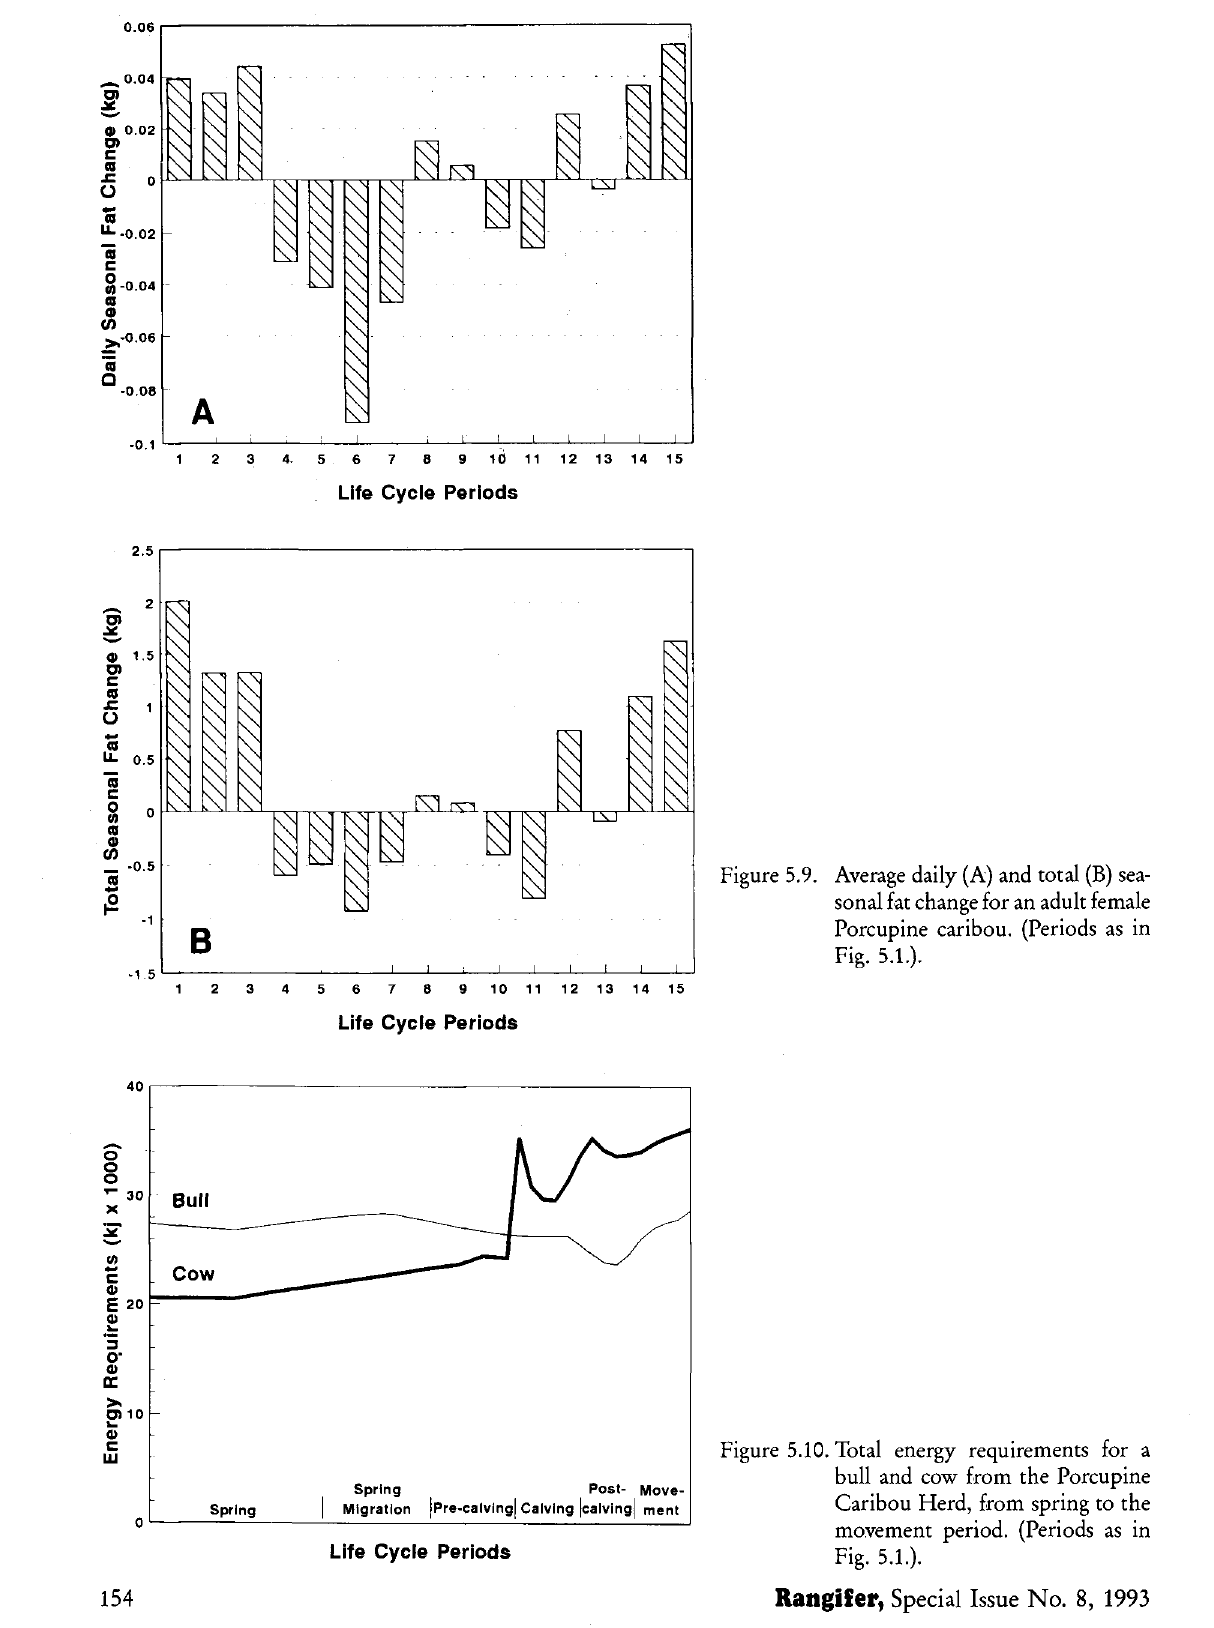
Figure 5.10. Total energy requirements for a bull and cow from the Porcupine Caribou Herd, from spring to the movement period. (Periods as in Fig.